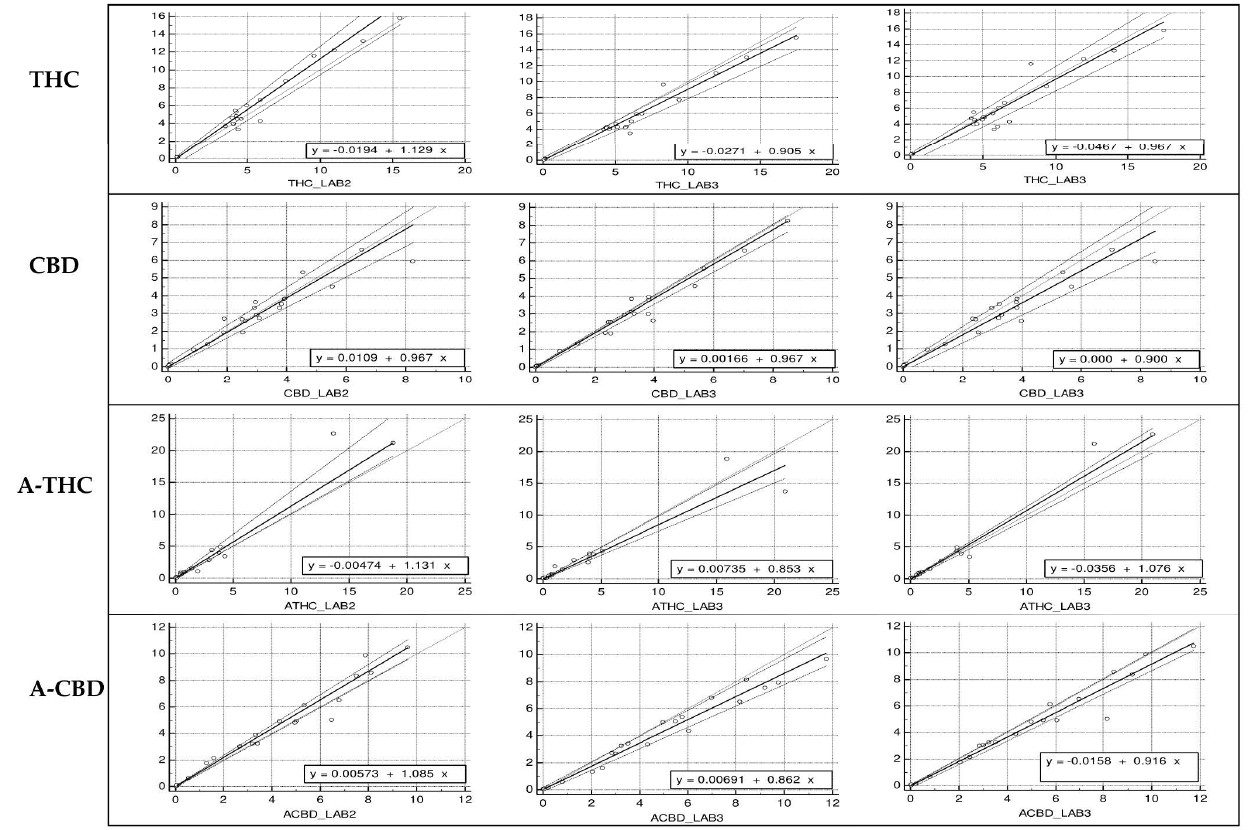
Figure 3. Passing Bablok correlation plots for THC, CBD, A–THC and A–CBD. The plots show excellent correlations between the three laboratories for both cannabinoids.